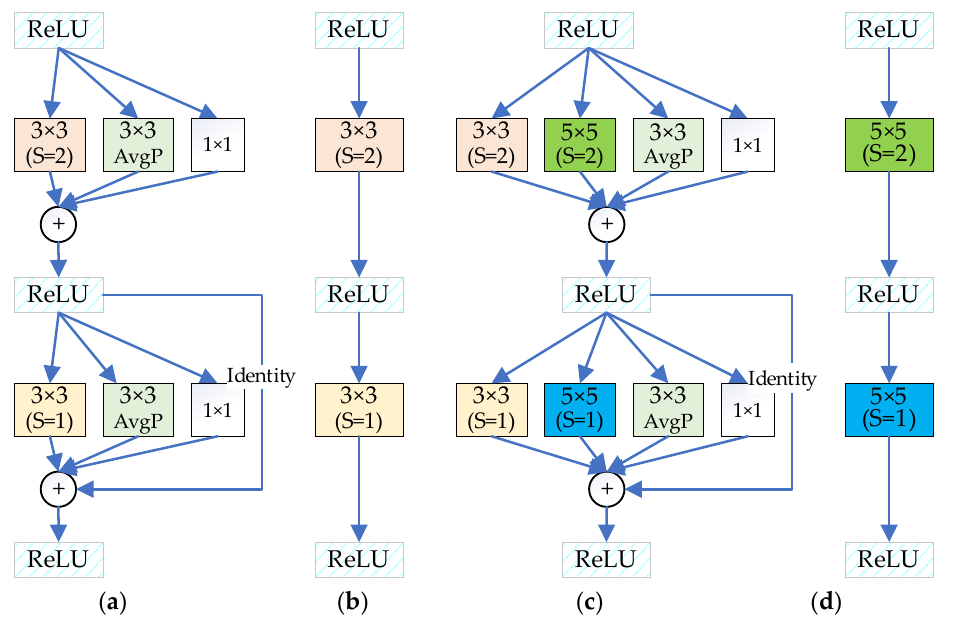
Figure 3. Inception-based branch-fuse. ( a ) Training (3 × 3); ( b ) Inference (3 × 3); ( c ) Training (5 × 5); ( d ) Inference (5 × 5).